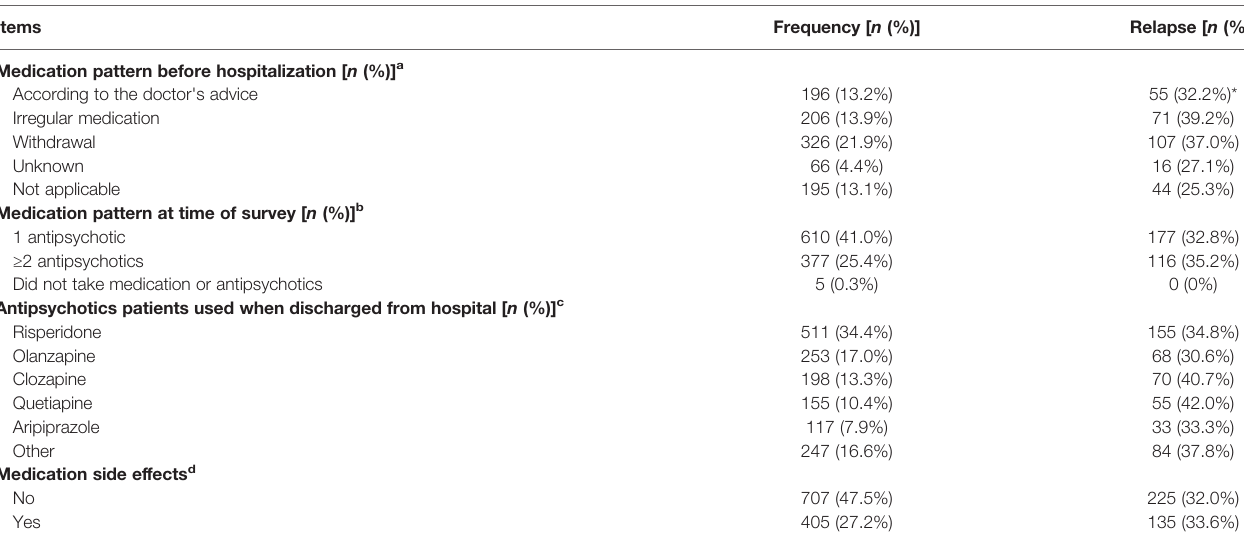
TABLE 1-3 | General demographic and disease information of the patients ( n =